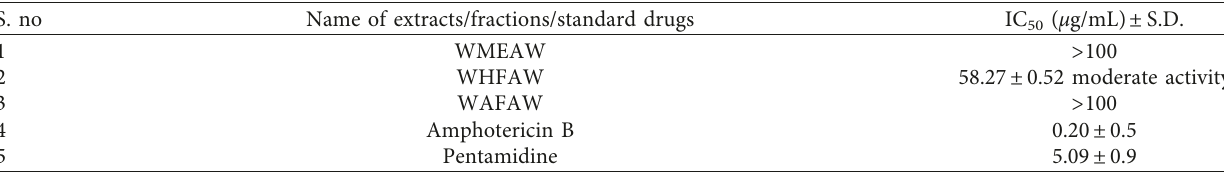
Table 1: Antileishmanial activities of extracts and fractions of whole plant of Achillea wilhelmsii . S. no